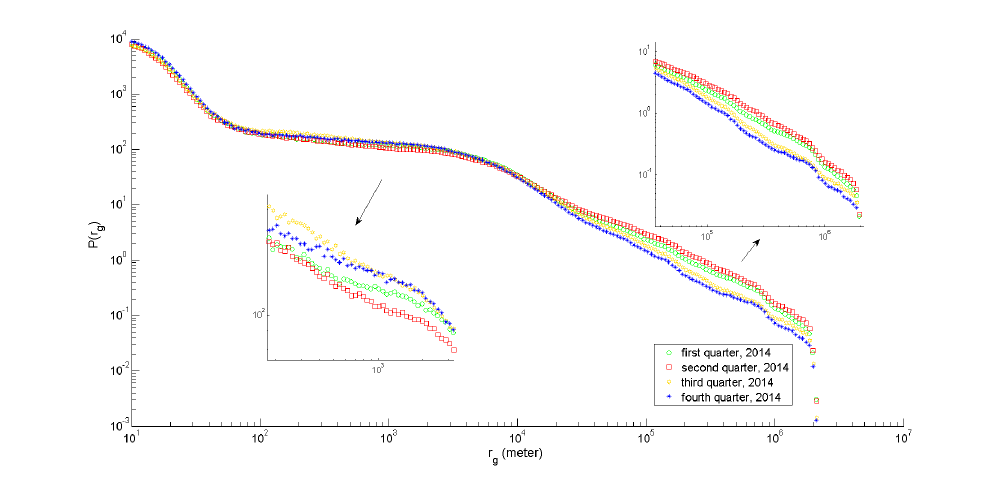
Figure 6. The probability distribution of radius of gyration of individual Twitter users in different quarters of the year